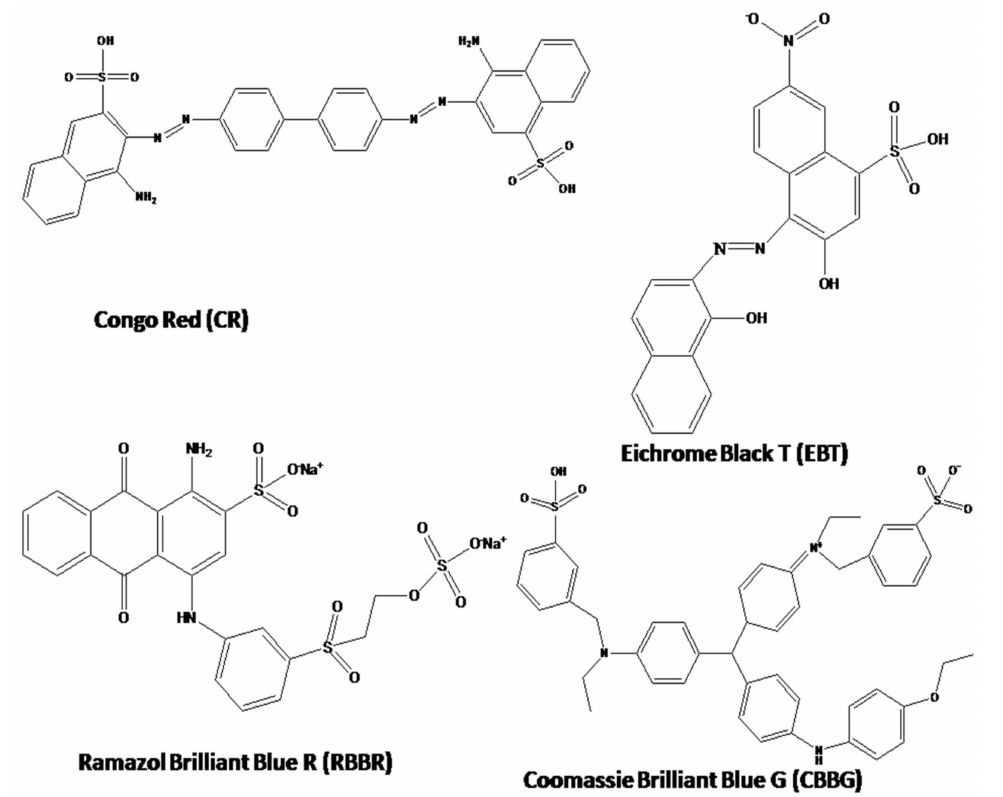
Figure 9. Molecular structures of the dyes utilized in present